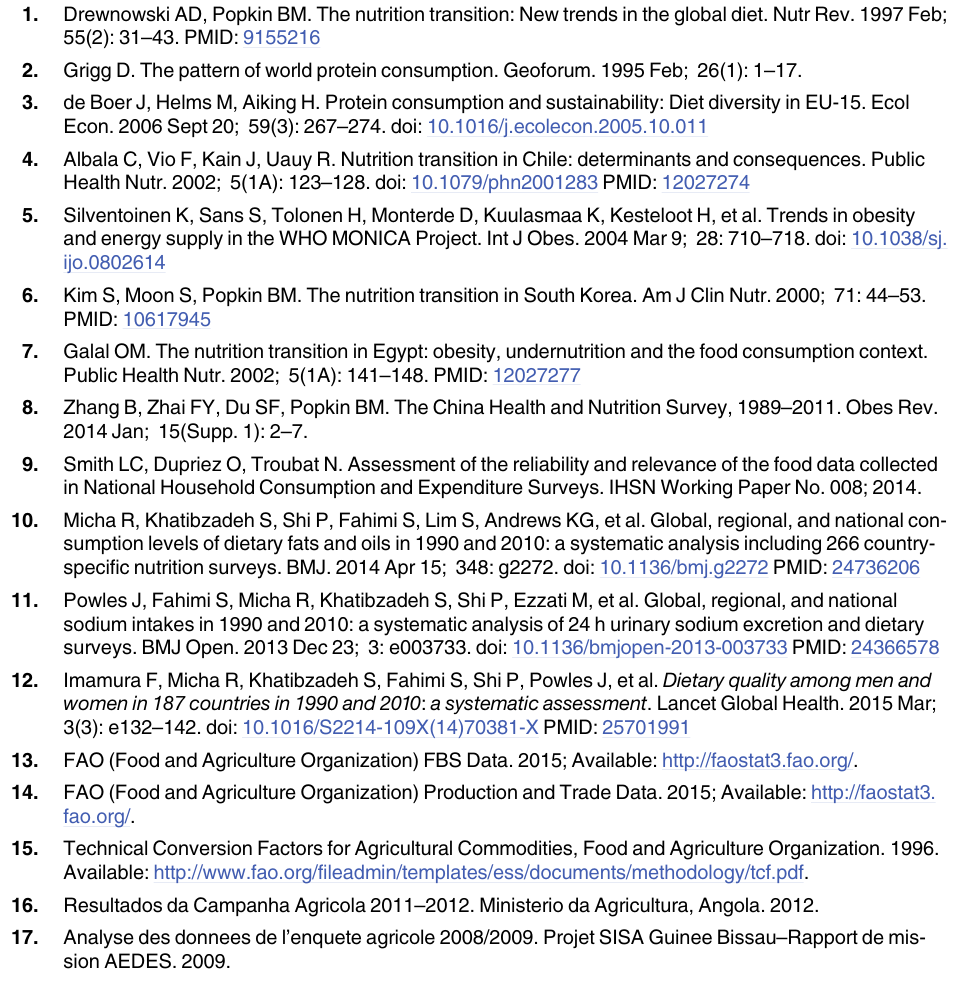
S2 Table. Fortified nutrients studied and their associated food